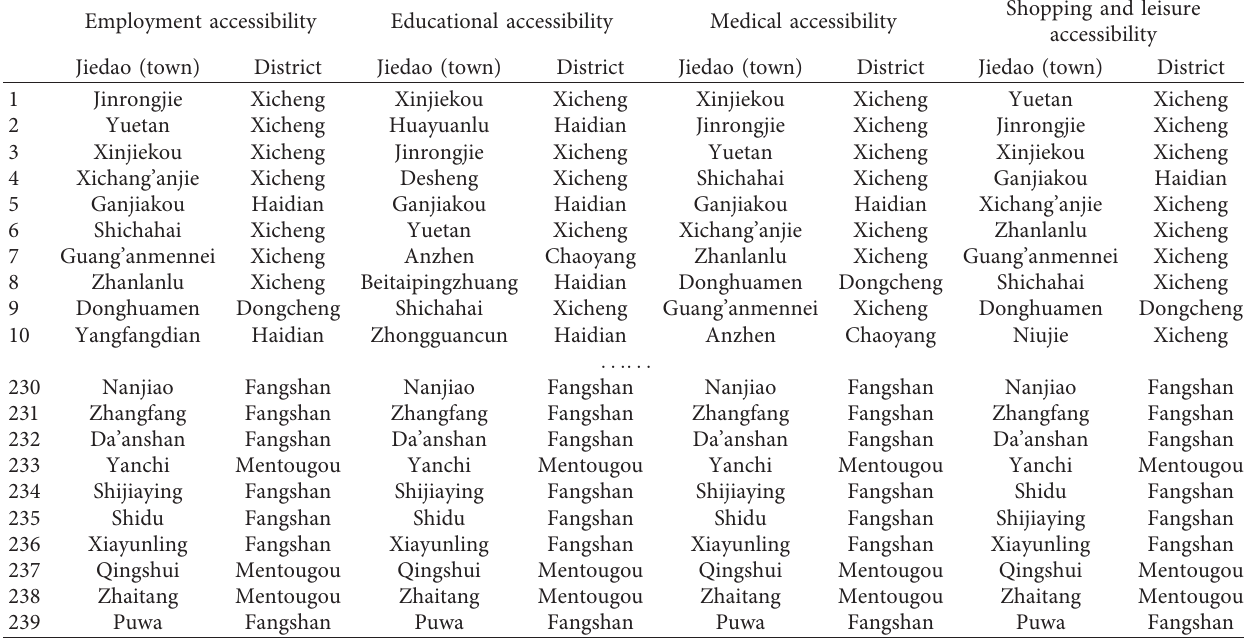
Table 1: The top and bottom ten towns for accessibility to different economic activities.